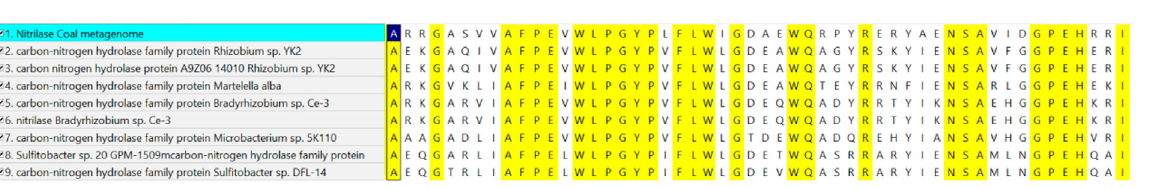
FIGURE 2 Multiple sequence alignment of the selected eight sequences with the identi fi ed novel nitrilase sequence. The highlighted residues are the conserved amino acid sequences. The identi fi ed nitrilase sequence from the coal metagenome showed similarity to the 39th site of the other selected protein